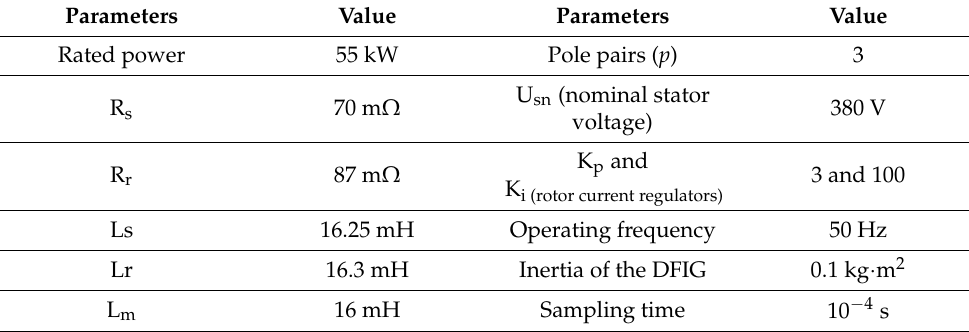
Table A1. DFIG and control system